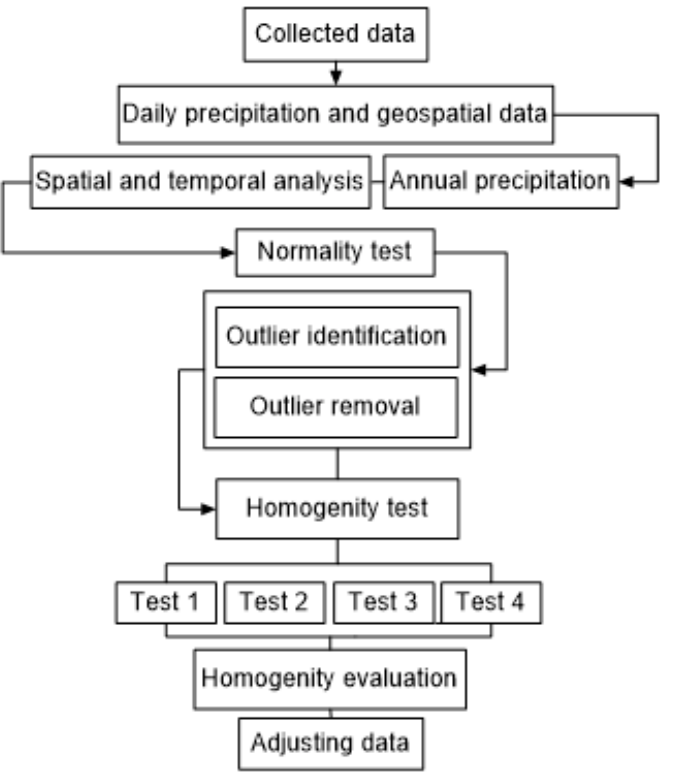
Figure 2. Flowchart representing the links between the main steps in the proposed research meth- odology.